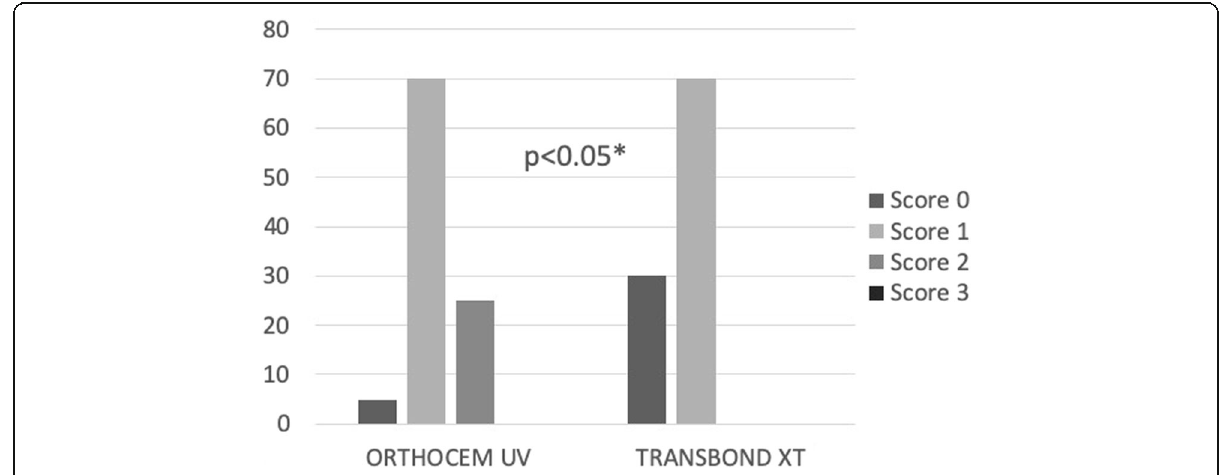
Fig. 2 Graphic illustration showed statistically significant differences in the ARI scores between the groups ( p =